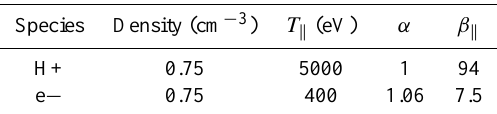
Fig. 8. Results for model 2. Same legend as Fig. 7 Table 1. Plasma model 1 corresponding to the period between 02:20 and 02:25UT with B 0 =